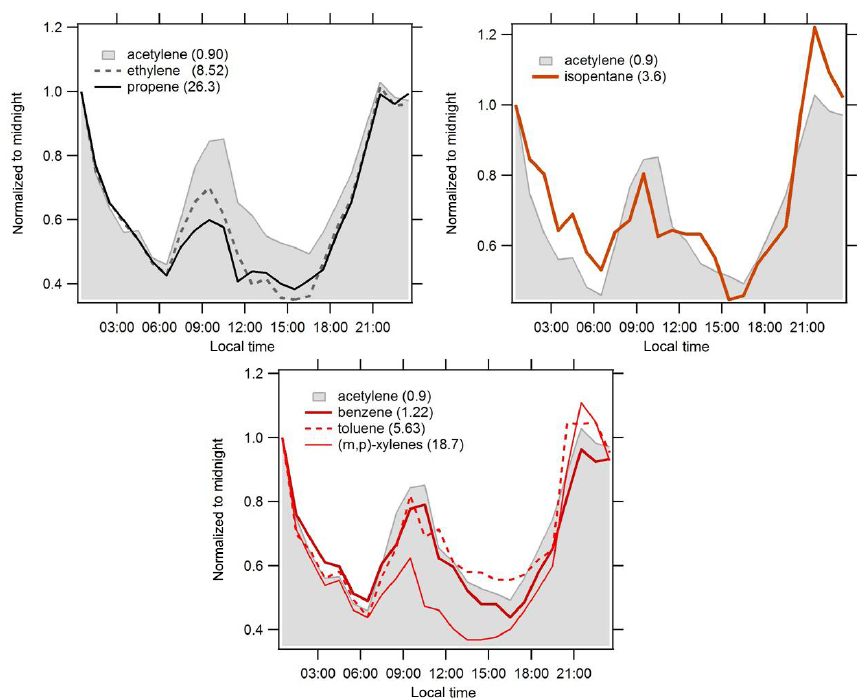
Figure 2. Normalized diurnal profiles of the mixing ratio of selected species to midnight values in summer. Numbers in parentheses are the rate coefficient with OH × 10 − 12 cm 3 molecule − 1 s − 1 (Atkinson and Arey, 2003; Atkinson,